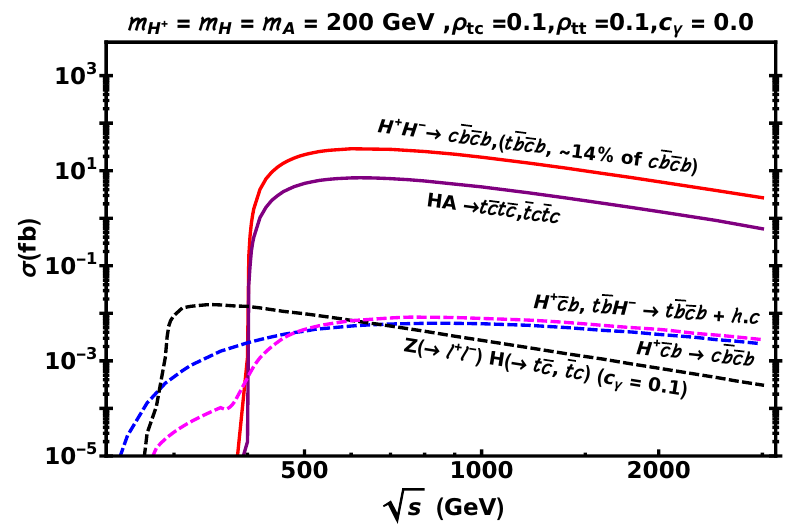
√ ¯ Figure 1 . Cross section vs s for e + e − → H + H − → c b ¯ cb (red, solid), HA → t ¯ ct ¯ c, ¯ tc ¯ tc (purple solid), Z ( → ‘‘ ) H ( → t ¯ c, ¯ tc ) (black, dashed, with c = 0 . 1 ), H + ¯ cb → c ¯ b ¯ cb (blue, dashed), and γ ¯ ¯ H + ¯ cb, t bH − → t b ¯ cb + h . c . (magenta, dashed). Note here that the c γ is nonvanishing only for Z ( → ‘‘ ) H ( → t ¯ c, ¯ tc ) process but set to zero for all other curves and throughout the